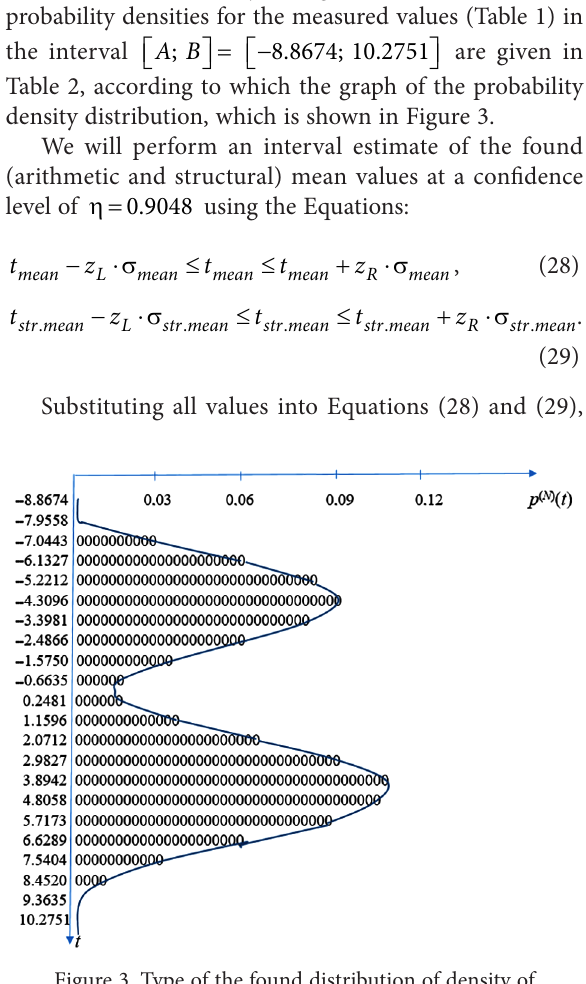
Figure 3. Type of the found distribution of density of probability of corrections. The graph is rotated by